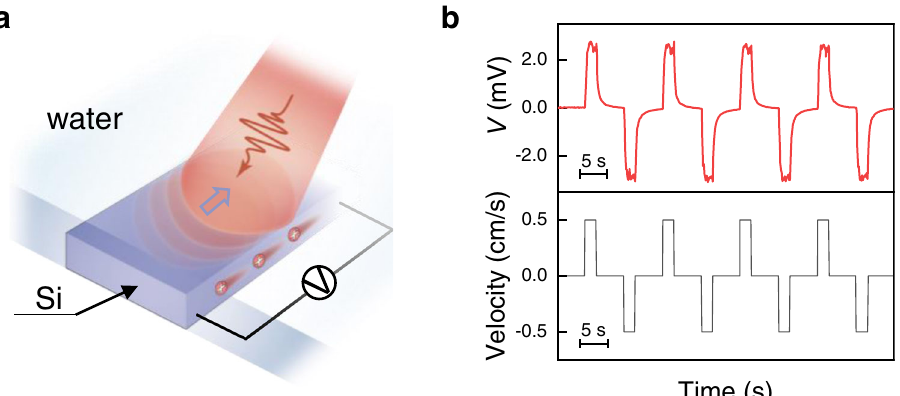
Fig. 1 In-plane photovoltage stimulated by scanning a light beam. a Schematic illustrating the device structure. In-plane voltage signal across two terminals of a silicon strip in water was recorded while scanning a light beam. b Velocity pro fi le of a light beam moving on a p-type Si strip (bottom, black) and the corresponding voltage signal (top,